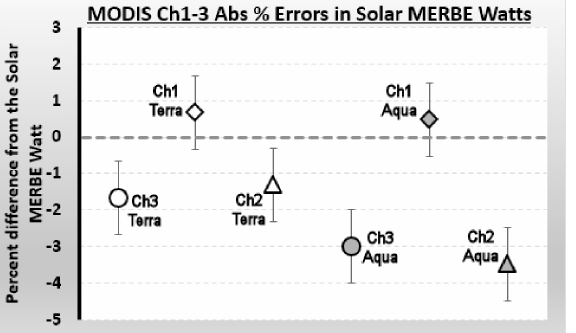
Figure 4. Estimates of absolute MODIS start of mission calibration errors in solar MERBE